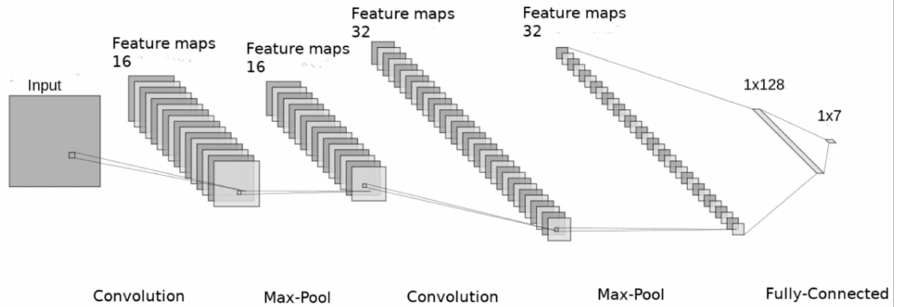
Figure 1. The structure of used convolutional neural network (CNN). Its input size changes to fit the size of feature vector (FVs) that varied across